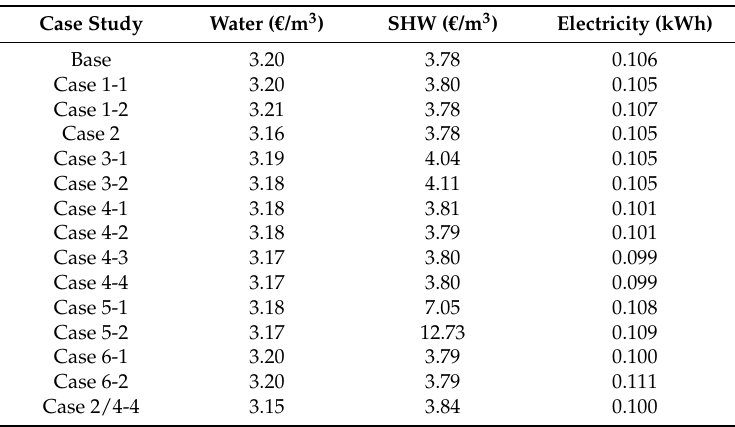
Table 12. Cost estimation in the sensitivity